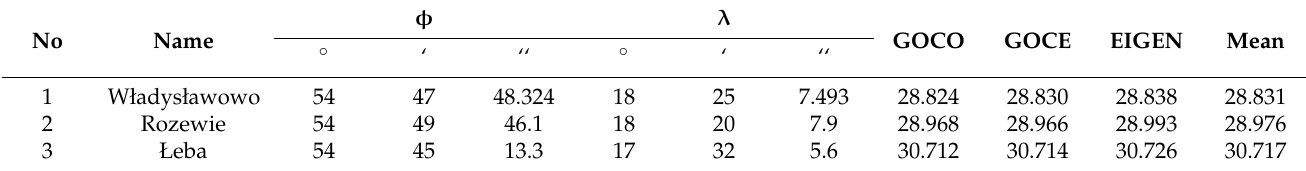
Figure 10. Spatial distribution of differences (GOCE-EIGEN) in meters. 5. Calculation of Quasigeoid Anomalies at Selected Tide Gauge Stations With the three versions of quasigeoid counted for the Baltic region, quasigeoid separa- tions were interpolated at three tide gauge stations in Władysławowo, Rozewie, and Łeba. The interpolation results are given in Table 7 and Figure 11. Table 7. Computed quasigeoid anomalies at tide gauge stations.